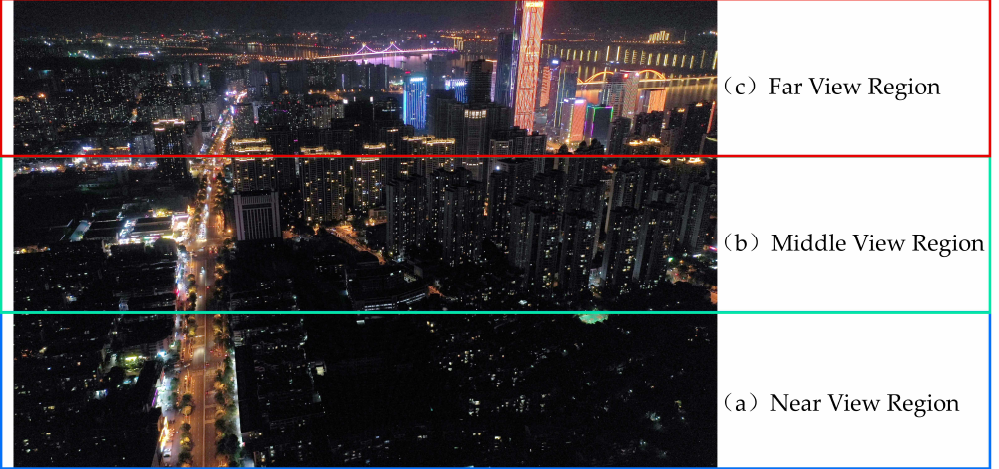
Figure 8. Guanshaling night lighting image and region division.